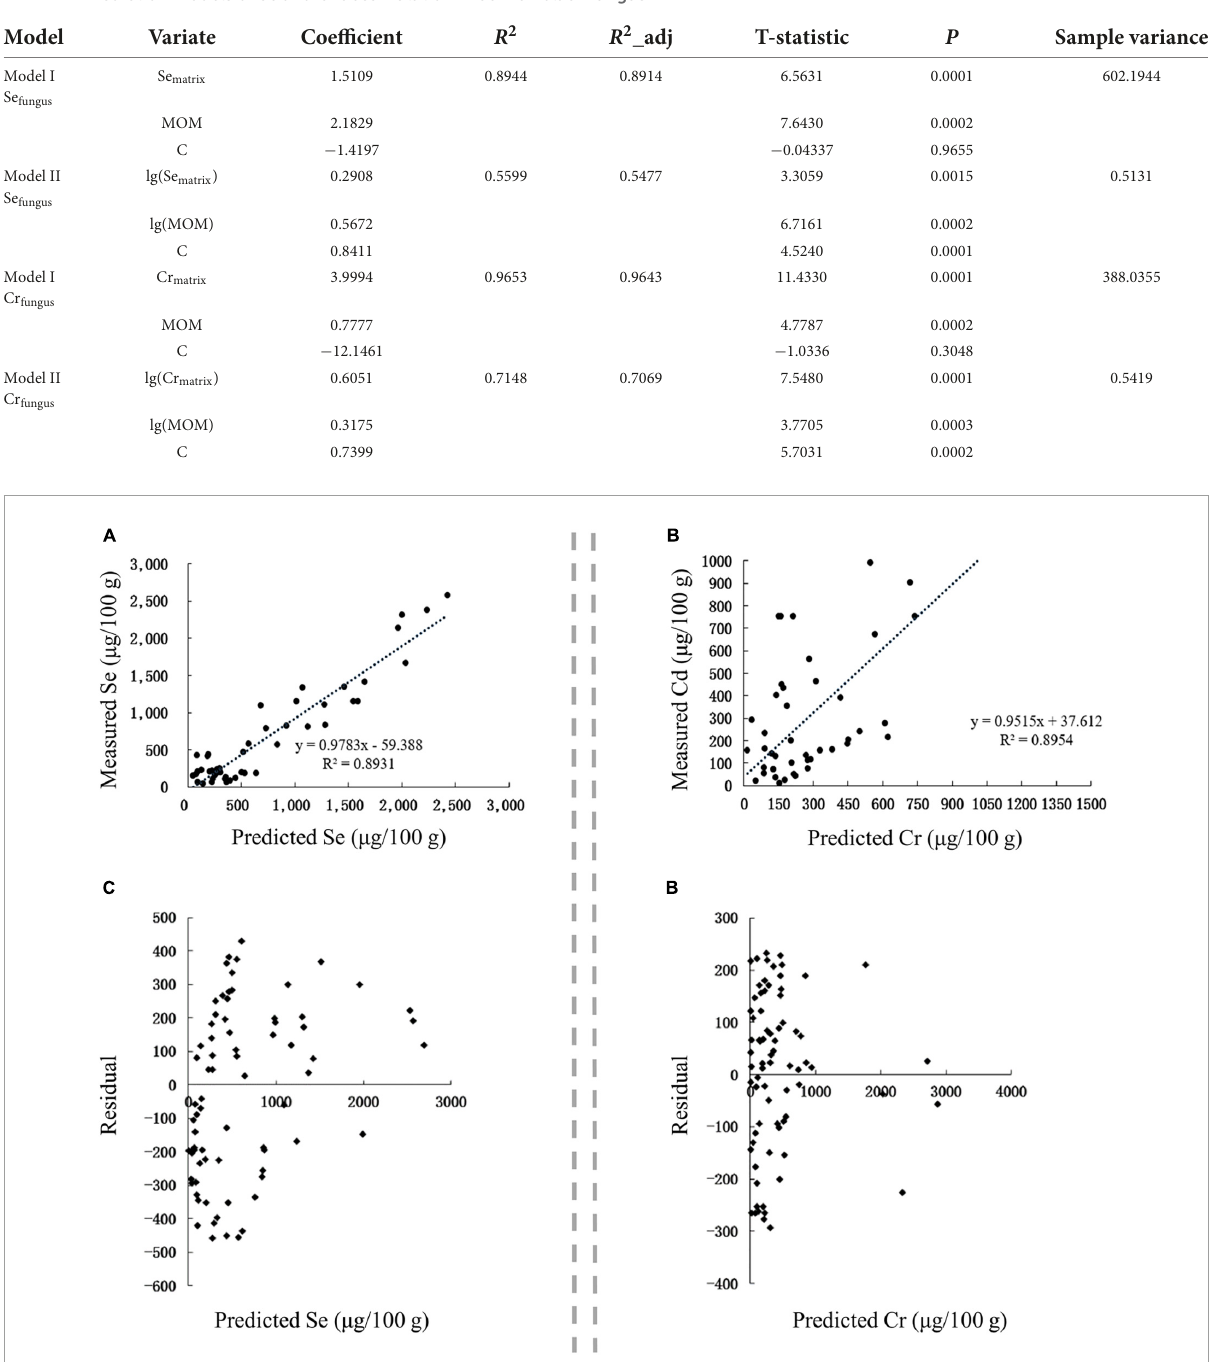
FIGURE9 Validation of prediction models in Se-rich black fungus. (A,B) Correlation between the predicted and measured Se and Cr contents, respectively. (C,D) Residual analysis of the fitted and measured Se and Cr contents,